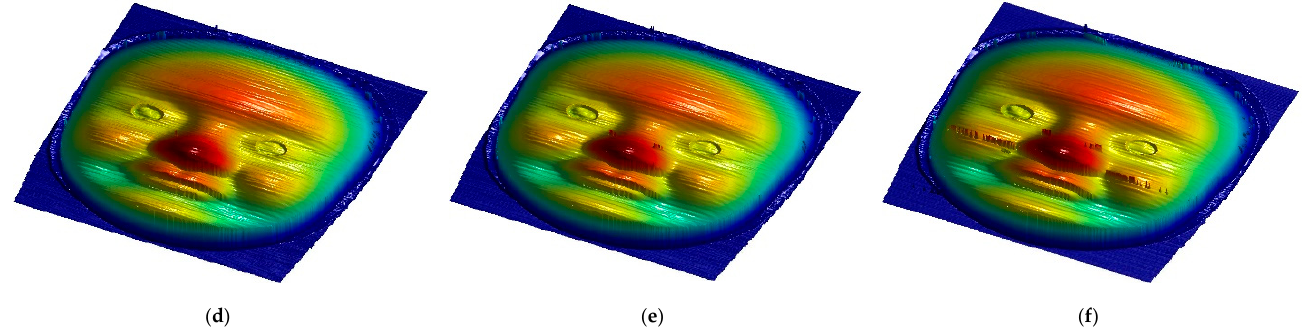
Figure 8. The recovered 3D results, ( a – c ) are conventional method and ( d – f ) are proposed method under different defocusing levels (From left to right: nearly focused, slightly defocused, and significantly defocused).